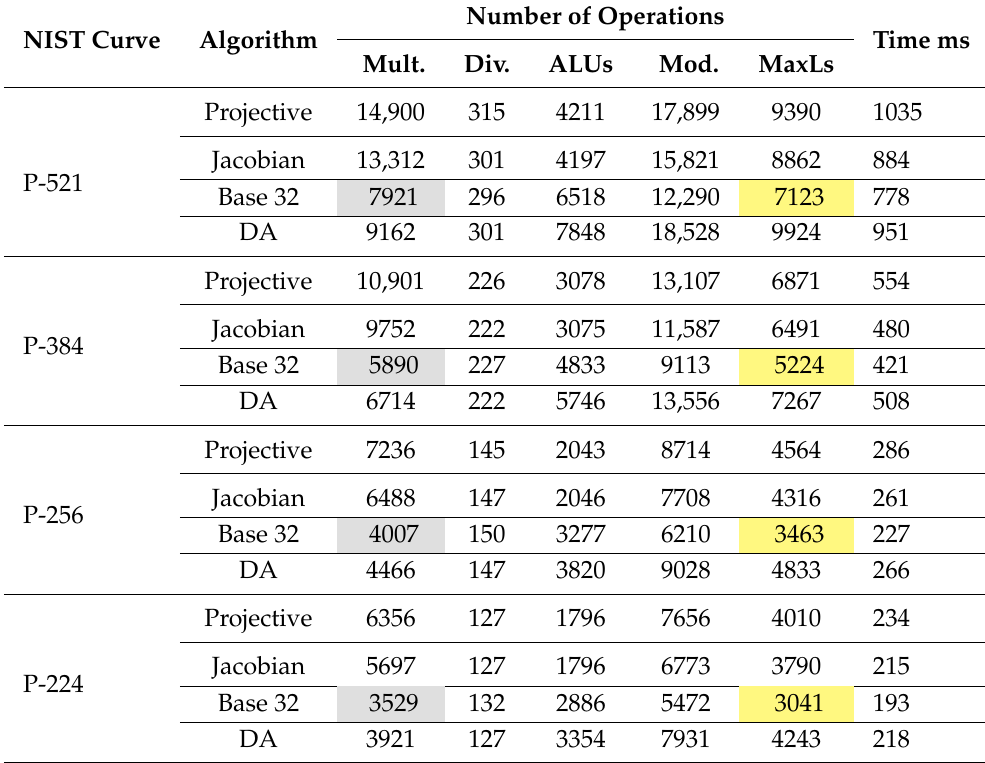
Table 4. EiSi Coordinates vs. Other Coordinates